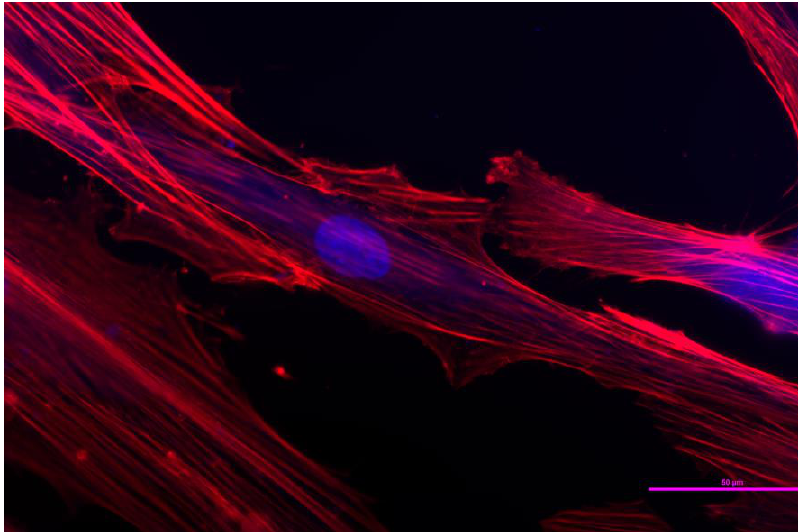
Figure 2. Representative optical fluorescent micrograph of control hMSCs, not subjected to interaction with the nanoparticles. Cells were stained for nucleus using DAPI (blue) and for f-actin cytoskeletal microfilaments using phalloidin (red). Scale bar equals 50 m.